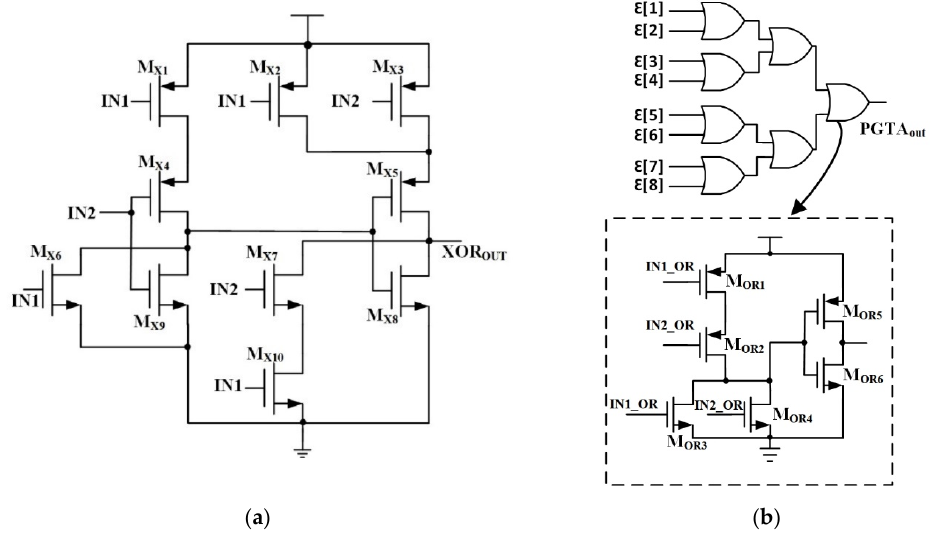
Figure 11. ( a ) Structure of the XOR gate; ( b ) structure of the OR gate in the PGTA.